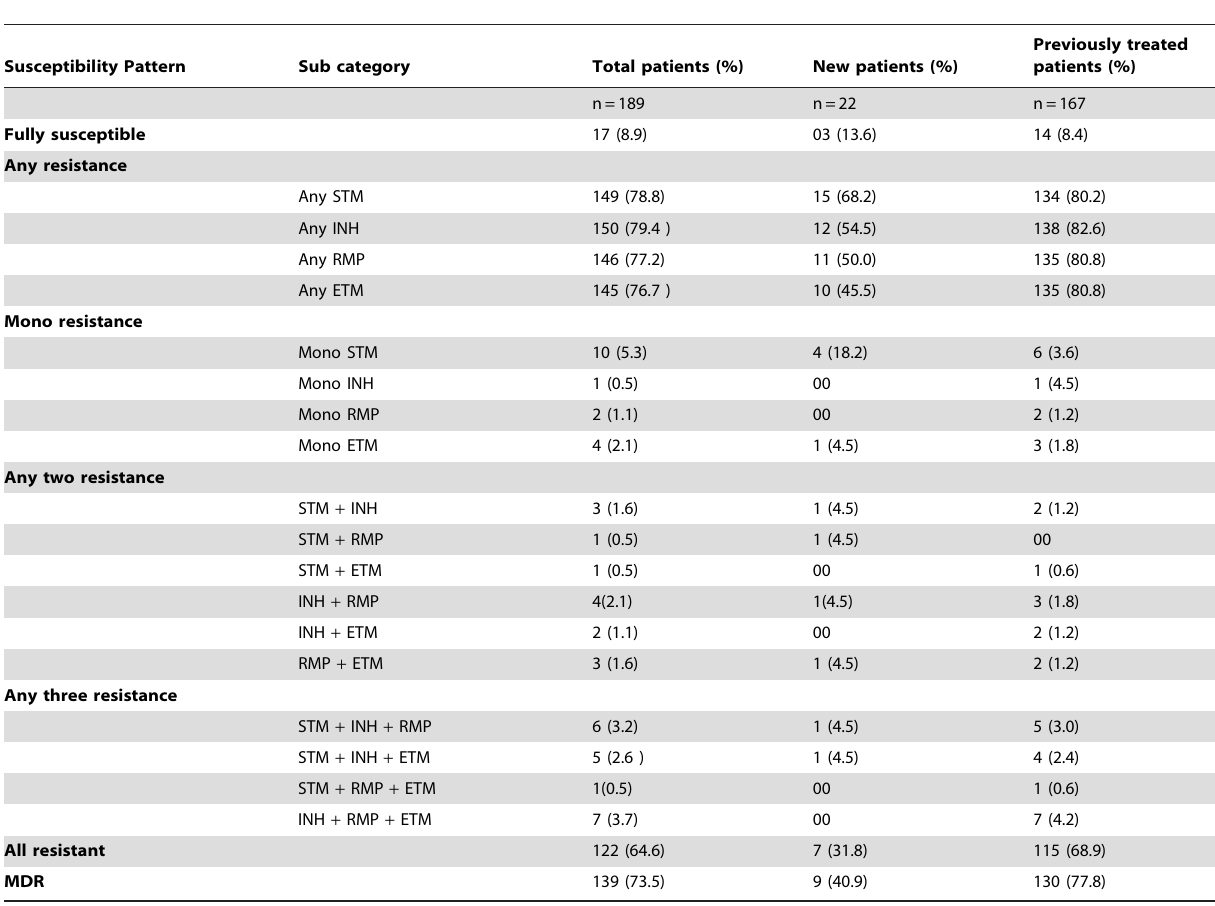
Table 3. Drug susceptibility pattern for M. tuberculosis clinical